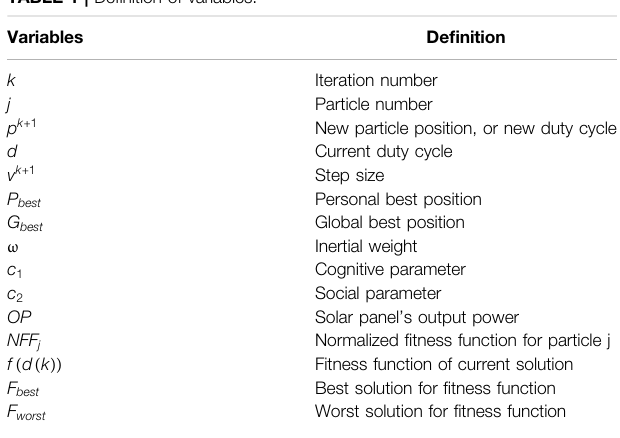
TABLE 1 | De fi nition of variables.